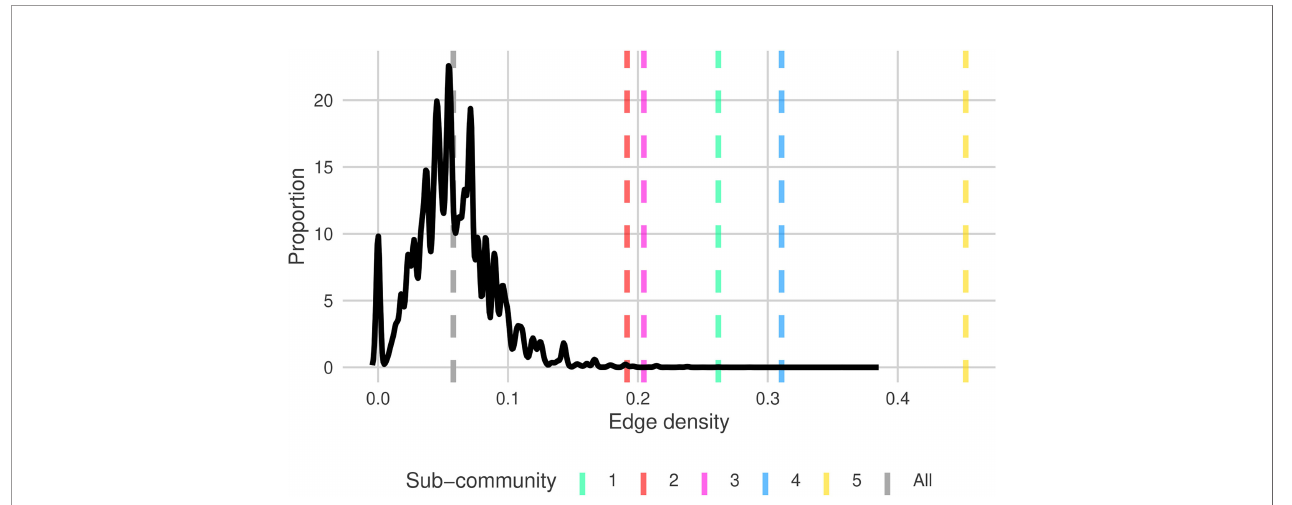
FIGURE 3 | Distribution of edge densities for random sub-graphs of size ∈ [7,16] (uniform random) from north Atlantic plankton community graph, G (solid black). Dashed grey and colored lines are the edge densities for G and each of the sub-communities G 1 ! G 5 , respectively. Sub-community line colors match the shaded regions in Figure 2